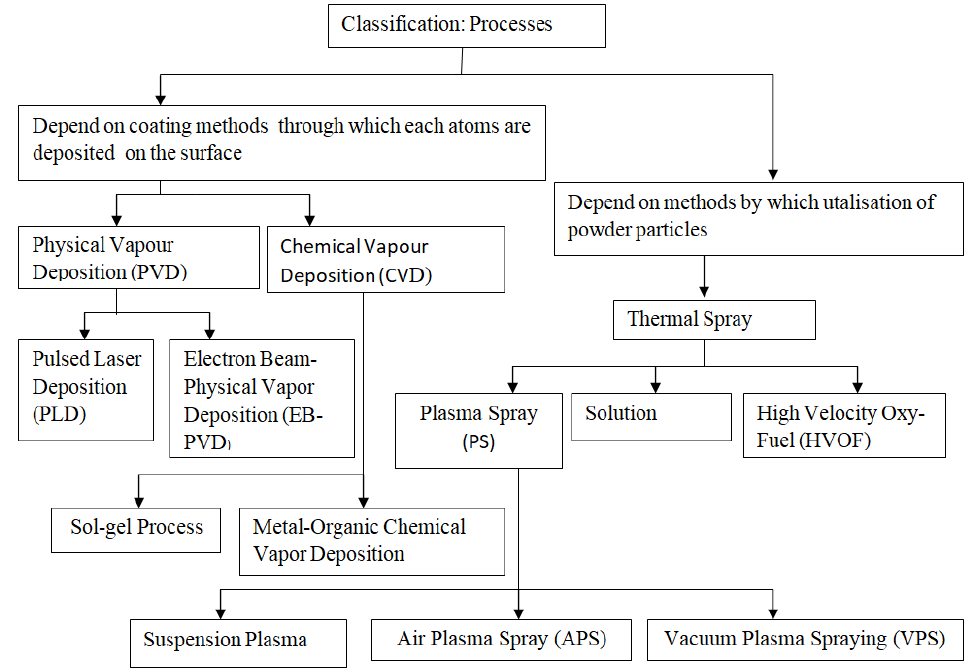
Figure 5. Wide classification of the coating process and methods used for material deposition.